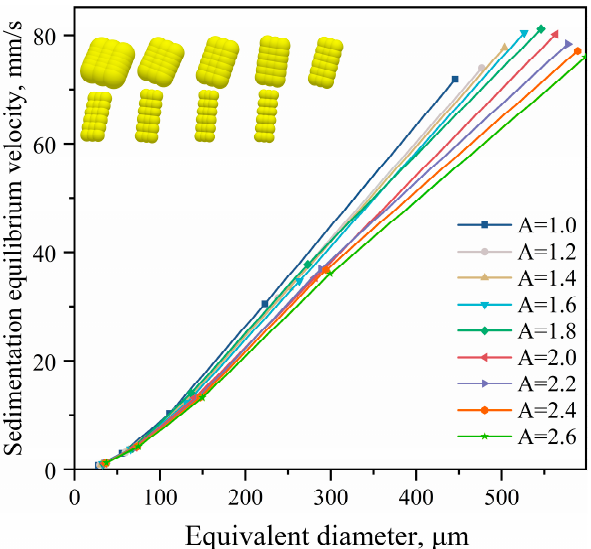
Figure 8. The relationship diagram of different long–middle axis ratios and particle sedimentation equilibrium velocity.